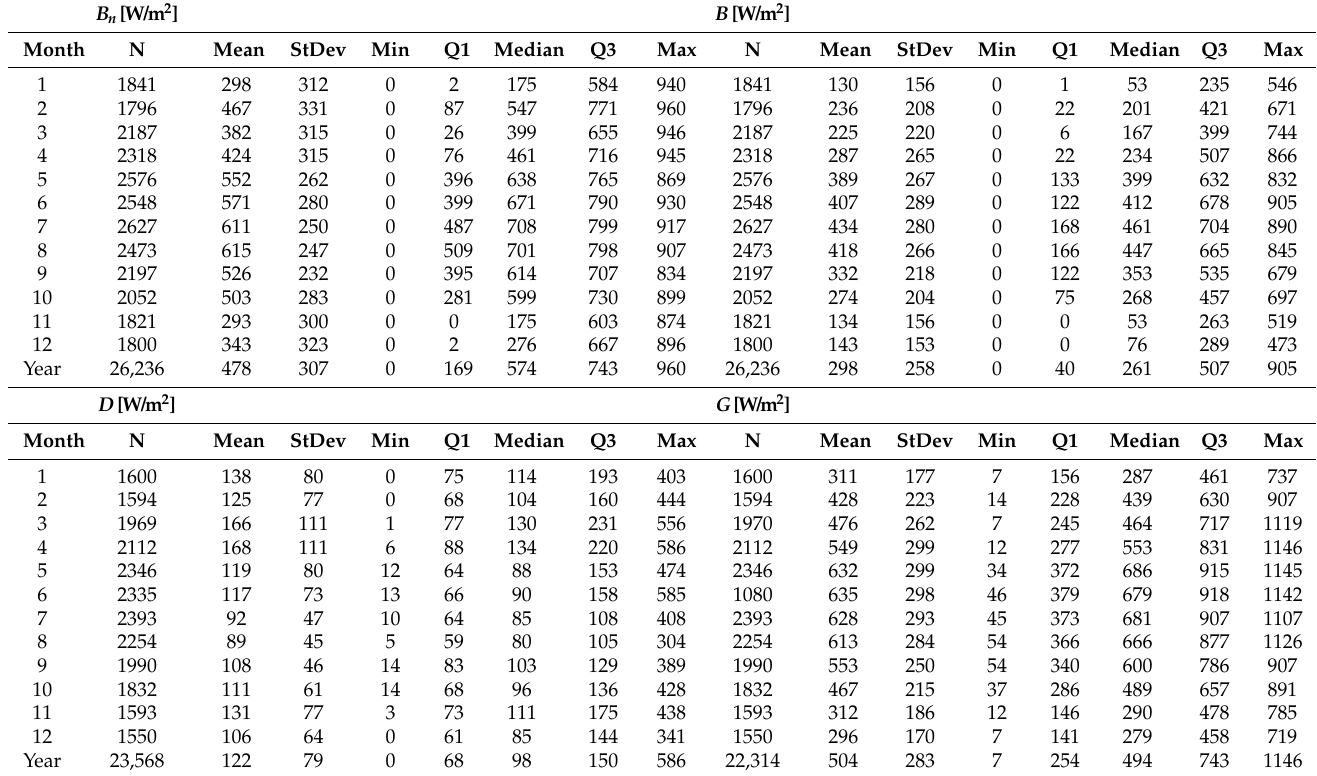
Table 5. Monthly descriptive statistics of the shortwave solar radiation components (W/m 2